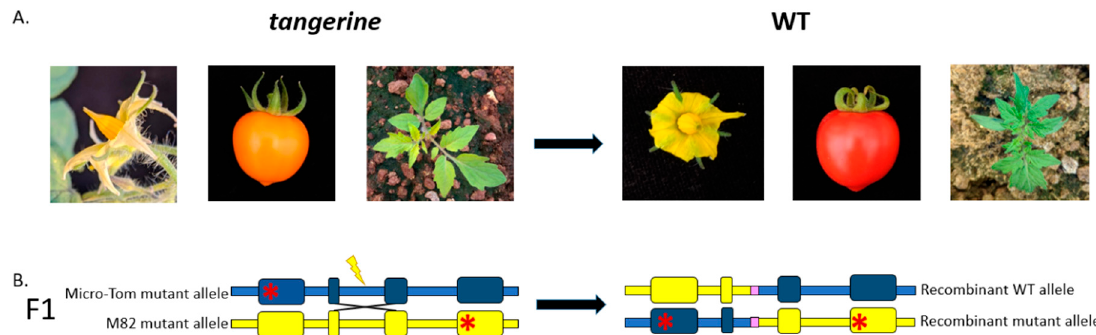
Figure 1. Phenotypic Inter-Homologous Somatic Recombination (IHSR) assay in the Carotenoid isomerase ( CRTISO ) gene utilizing visible gain-of-function events in F 1 plants. ( A ) CRTISO recessive mutant tangerine phenotypes seen as pale yellow petals, orange fruits, and yellowish young leaves. IHSR can lead to the correction of one mutant allele to the dominant WT allele and hence the plant will show WT phenotypes of yellow petals, red fruit, and green young leaves. ( B ) F 1 hybrid has two recessive CRTISO alleles (schematic not-to-scale representation). Each allele mutation is represented by a red asterisk. Exons are shown as wide boxes. The Micro-Tom background is blue and the M82 background yellow. The lightning bolt corresponds to a DSB site; the NHEJ footprint is in pink; and the X structure shows the site of IHSR repair induced by double-strand break (DSB). IHSR can generate recombinant WT or mutant alleles. NHEJ footprints that would occur after IHSR repair are not expected to change the WT phenotype since the DSB sites are in introns in non-splicing sites.